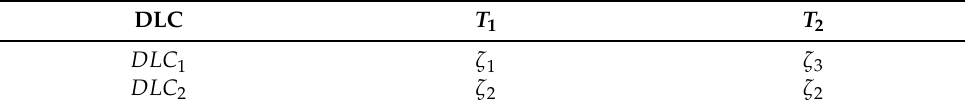
Table 8. Damping